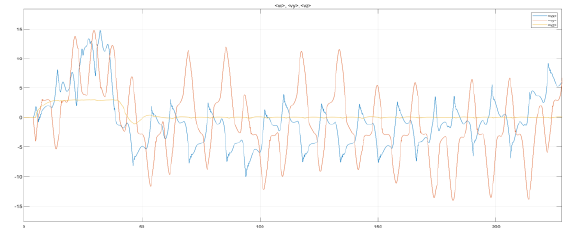
Figure 31. R angular velocity around Z - axes for the QAV